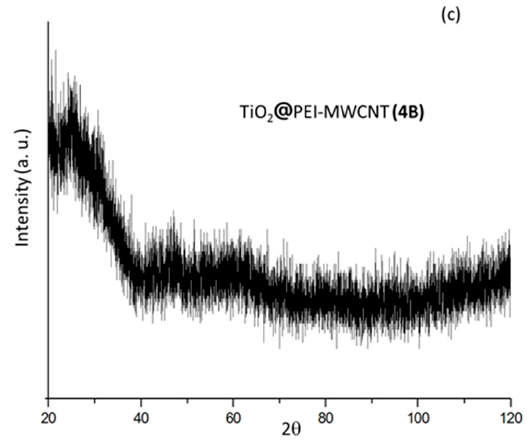
Figure 4. XRD patterns of samples ( a ) 4 ; ( b ) 1A ; ( c ) 4A-B .